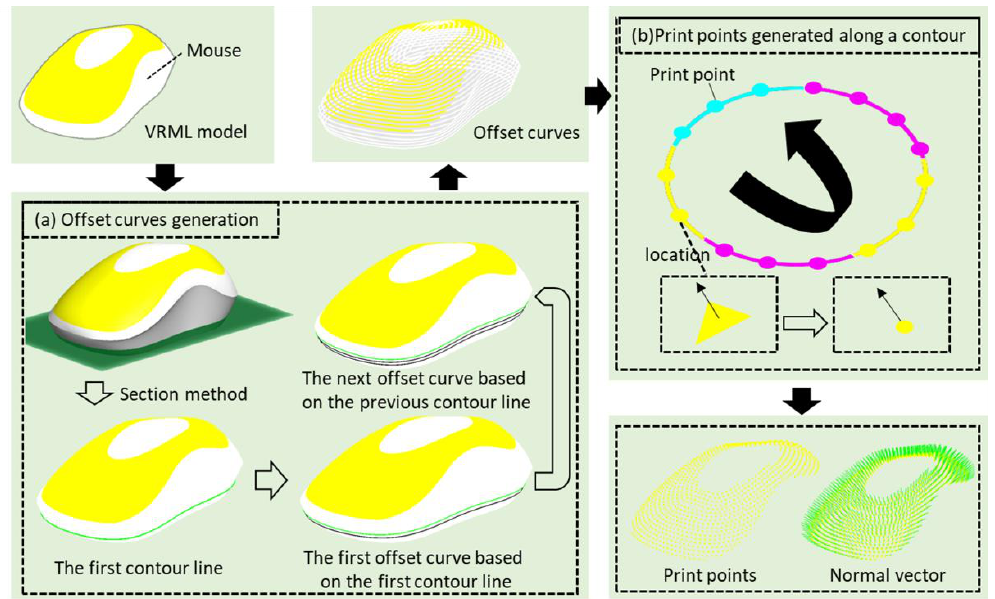
Figure 5. Process of the offset curve path planning (OCPP). VRML: virtual reality modeling language.